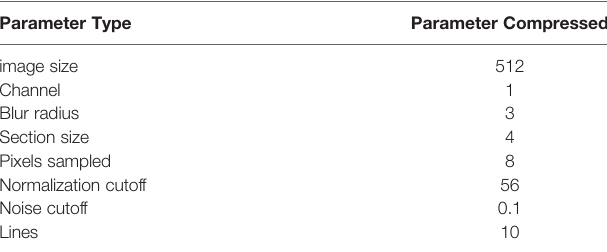
TABLE 1 | IJOQ Calibration settings of a B. pertussis infection on bronchial epithelial cells. Parameter